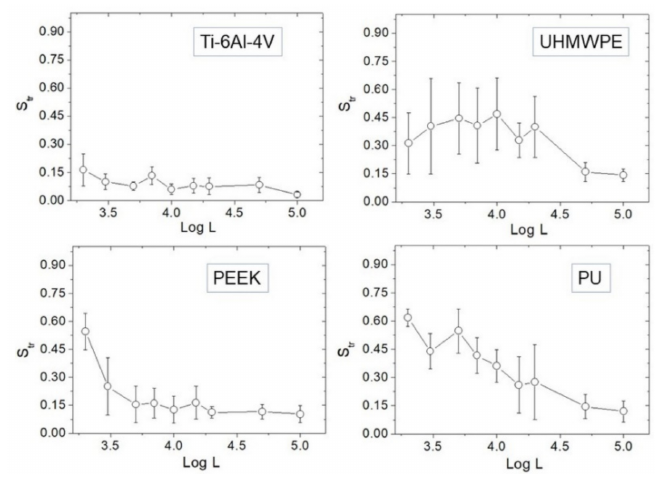
Figure 5. Plots of S tr against Log L for each